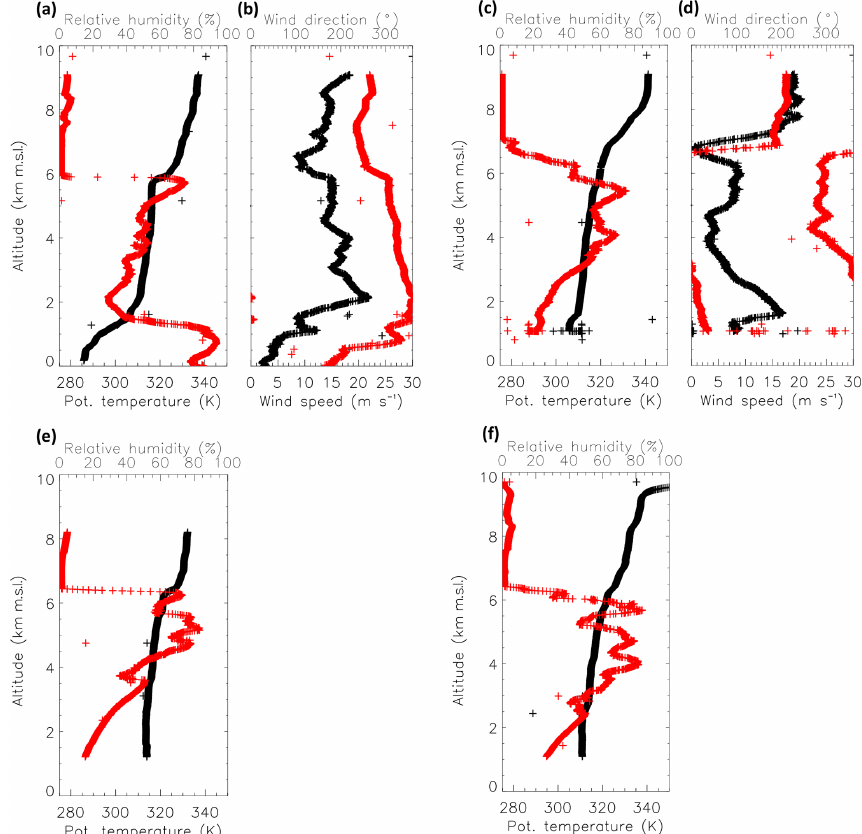
Figure 11. (a) Potential temperature (black) and relative humidity (red) profiles and (b) wind speed (black) and wind direction (red) profiles derived from the dropsonde launched at 09:51UTC on 5 September. (c) and (d) : same as (a) and (c) , respectively, but for the dropsonde released at 08:39UTC. (e) Same as (a) but for the dropsonde released at 13:37UTC on 6 September. (f) Same as (e) but for the dropsonde released at